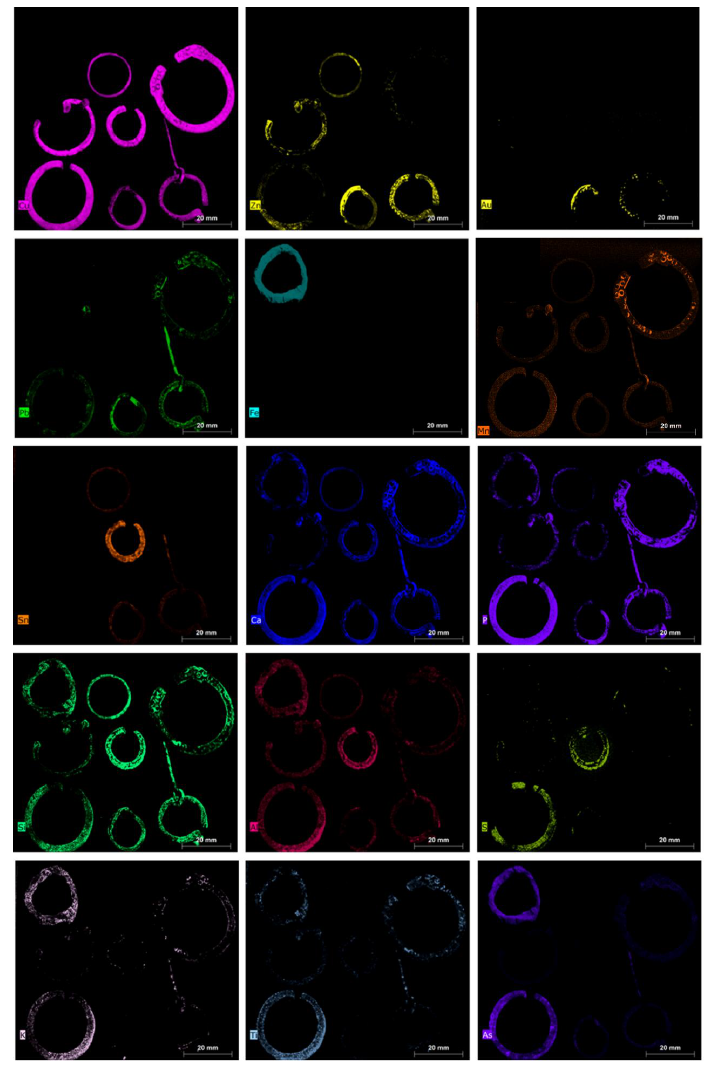
Figure 6. Elemental maps for all detected elements of fibula/ring/earring group. In order to better highlight the compositional analogies between the objects, PCA was applied to the XRF spectra. The results of this analysis are reported both as score plots of the PCs and as loading plots that relate the variance with the XRF emission lines (Figures 9 – 11).